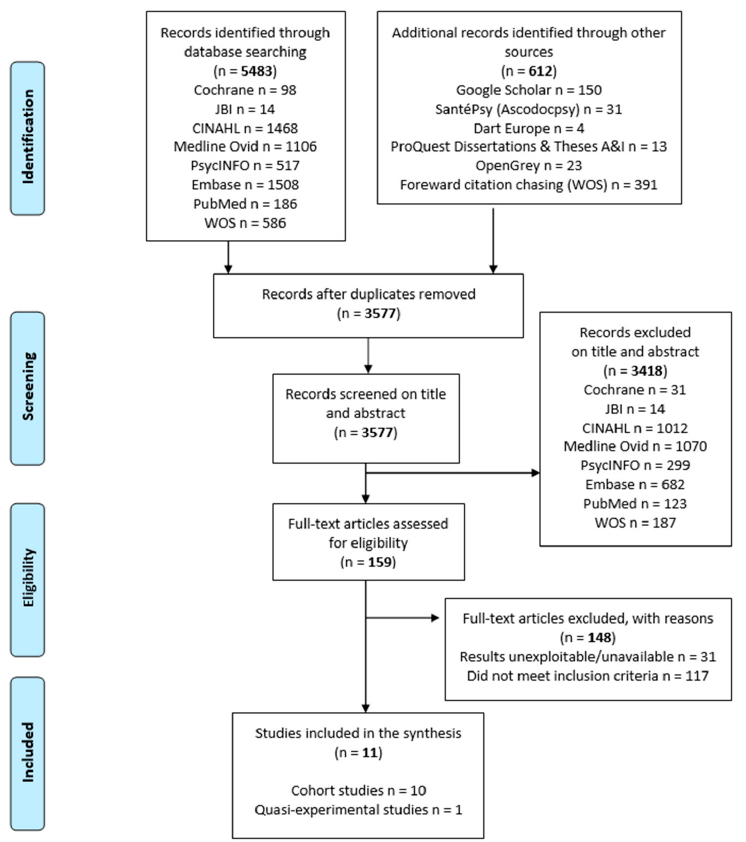
Figure 1. Flow diagram summarizing the results of our search strategy based on the PRISMA rec- ommendations